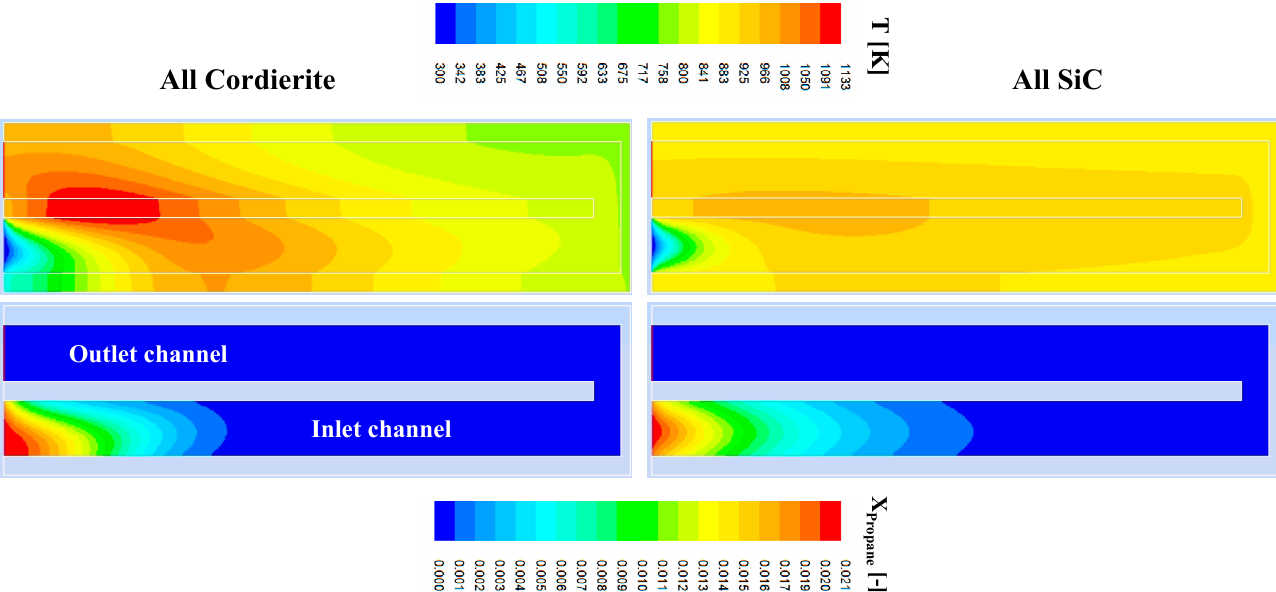
Figure 3. Maps of temperature, T, and propane mole fraction, X Propane , at V in = 0.5 m/s: All Cordierite; All SiC. A scaling factor equal to 2 was used to scale the computational domain along the transverse direction.